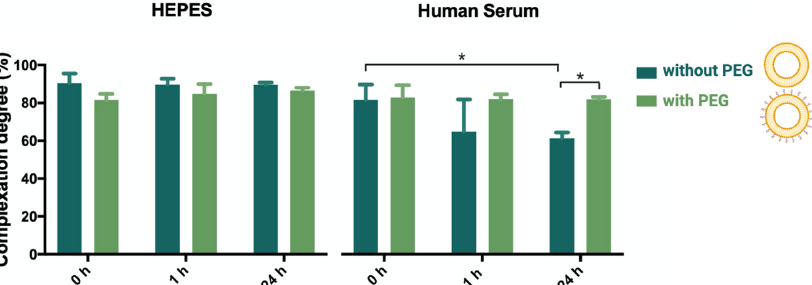
Figure 2. Percentage of association degree between liposomes and ONs in lipoplexes (without PEG) and PEGylated lipo- and PEGylated lipoplexes (with PEG), determined by single-color FCS analysis in HEPES buffer and plexes (with PEG), determined by single-color FCS analysis in HEPES buffer and in undiluted human serum at 0, 1 and in undiluted human serum at 0, 1 and 24 h incubation, at 37 ◦ C. Three independent experiments 24 h incubation, at 37  C. Three independent experiments were done. Results are represented as mean values and respec- tive standard deviations. Statistical differences are indicated when appropriate ( p ≤ 0.05, *). were done. Results are represented as mean values and respective standard deviations. Statistical